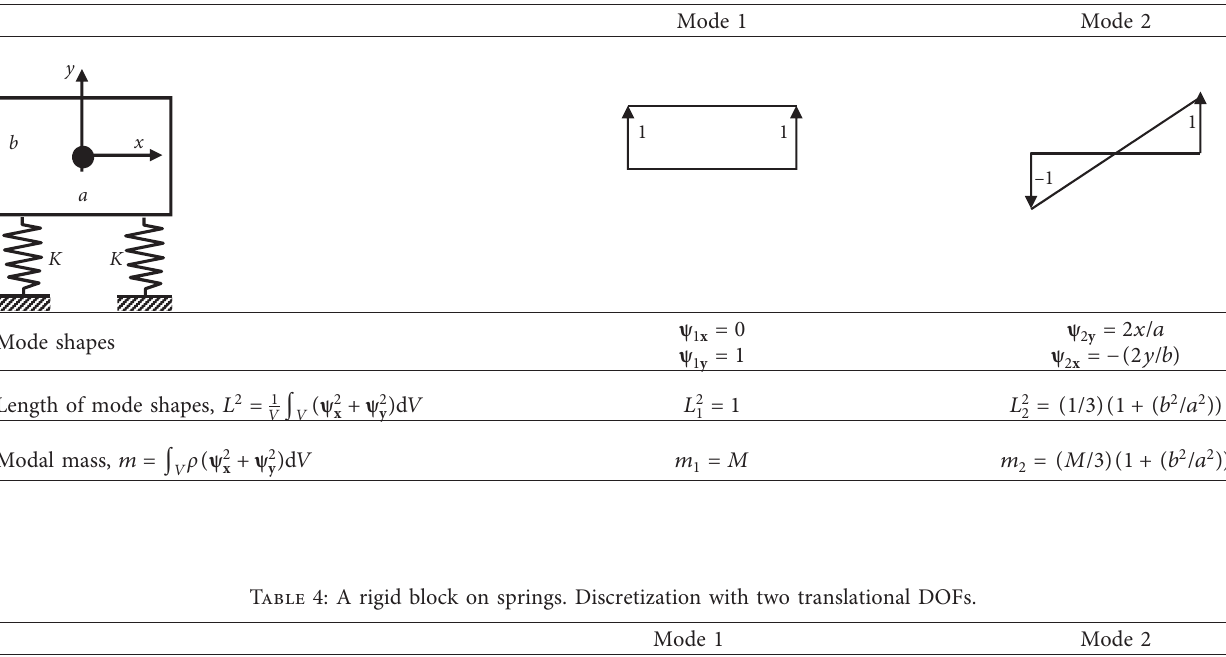
Table 3: A rigid block on springs. Continuous formulas.